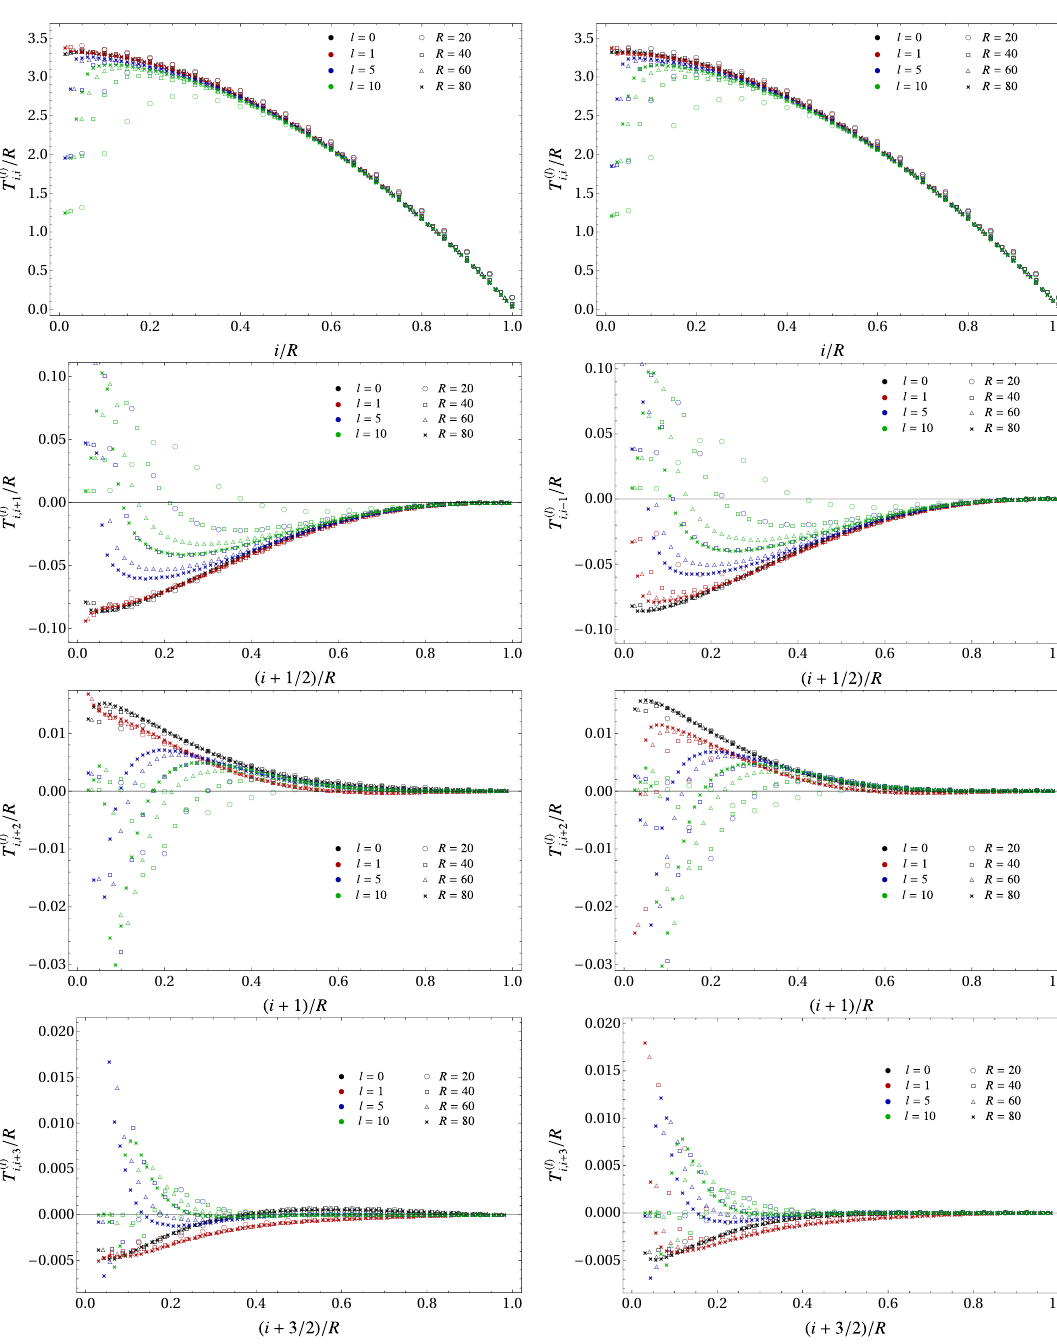
Figure 1. Short-range couplings in the matrix T ( l ) /R (see (3.2) and (3.5)) when ω = 0 and either d = 2 (left panels) or d = 3 (right panels), for some small l ’s and different sizes R